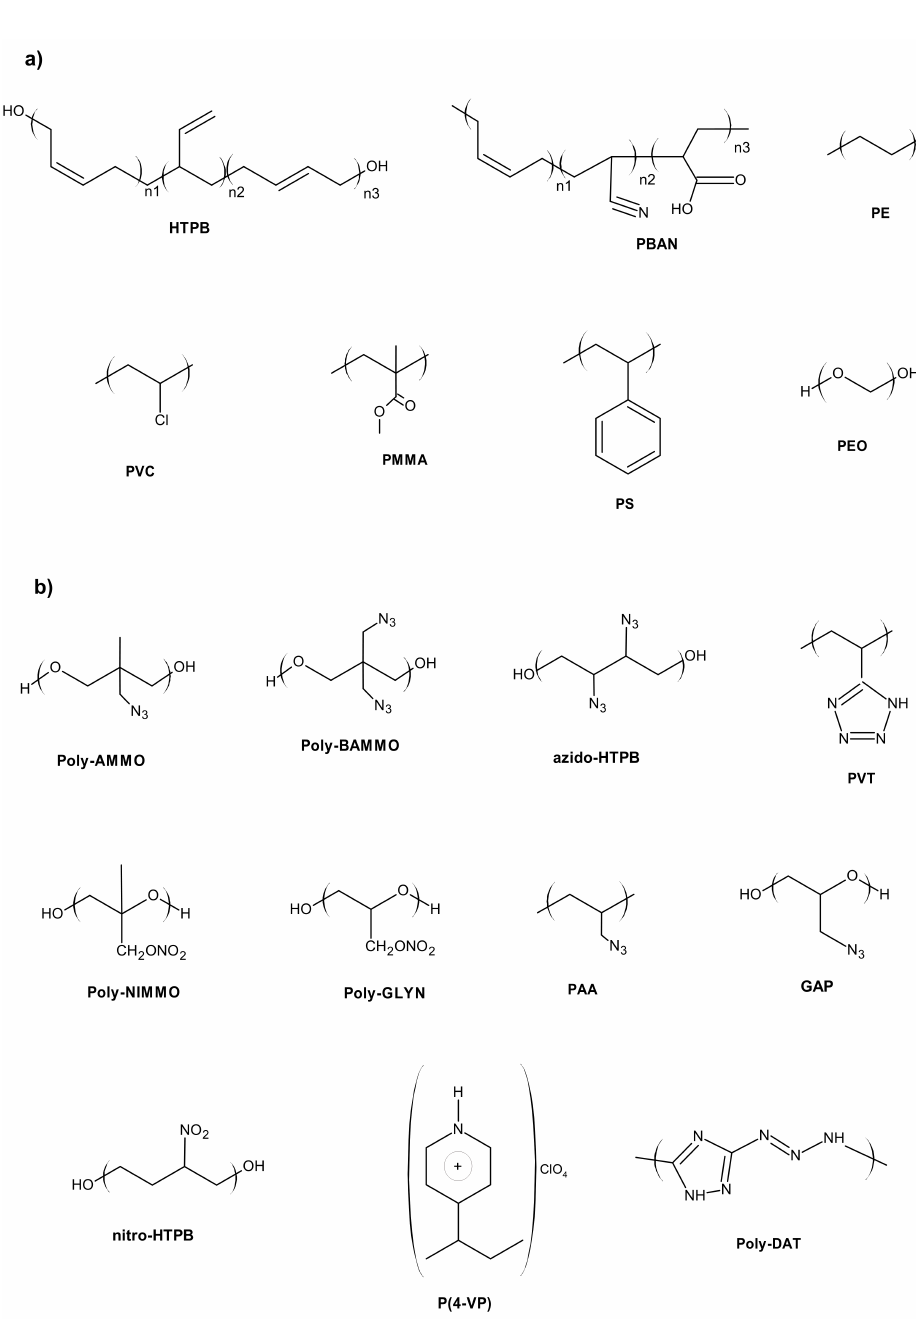
Figure 1. Chemical structures of the most commonly used binders: ( a ) non-energetic; ( b ) ener- getic